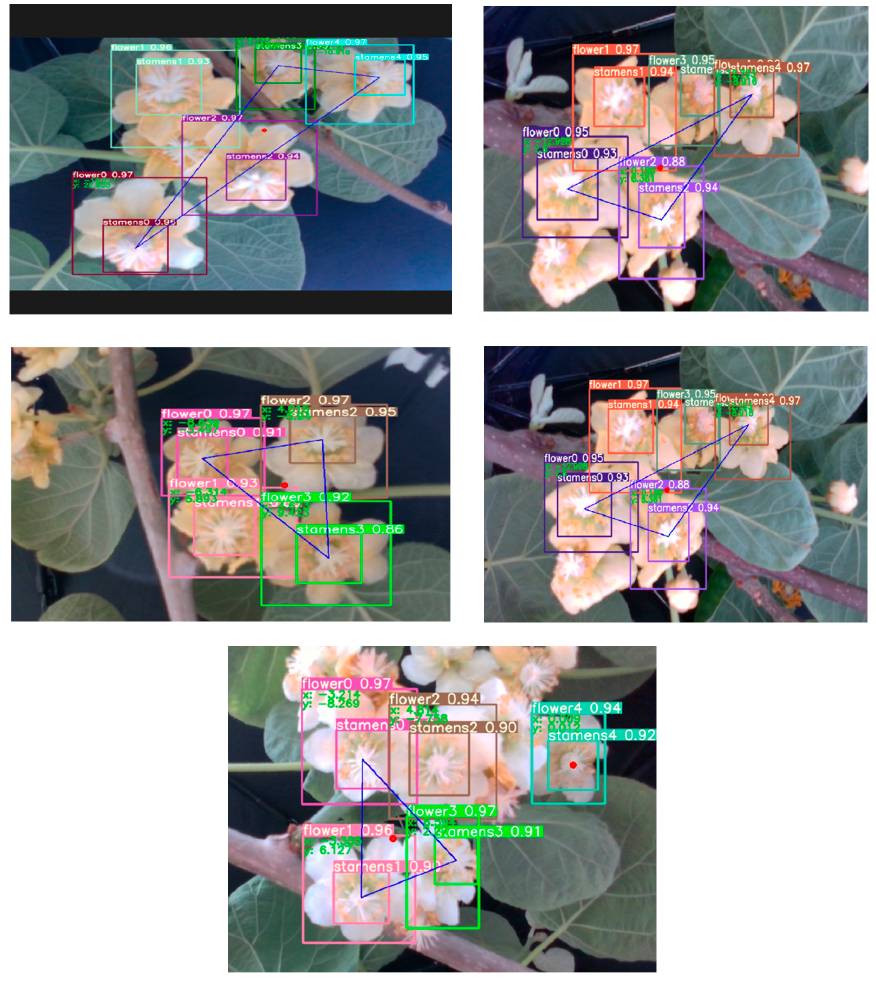
Figure 15. Inference result diagram of the detection function.